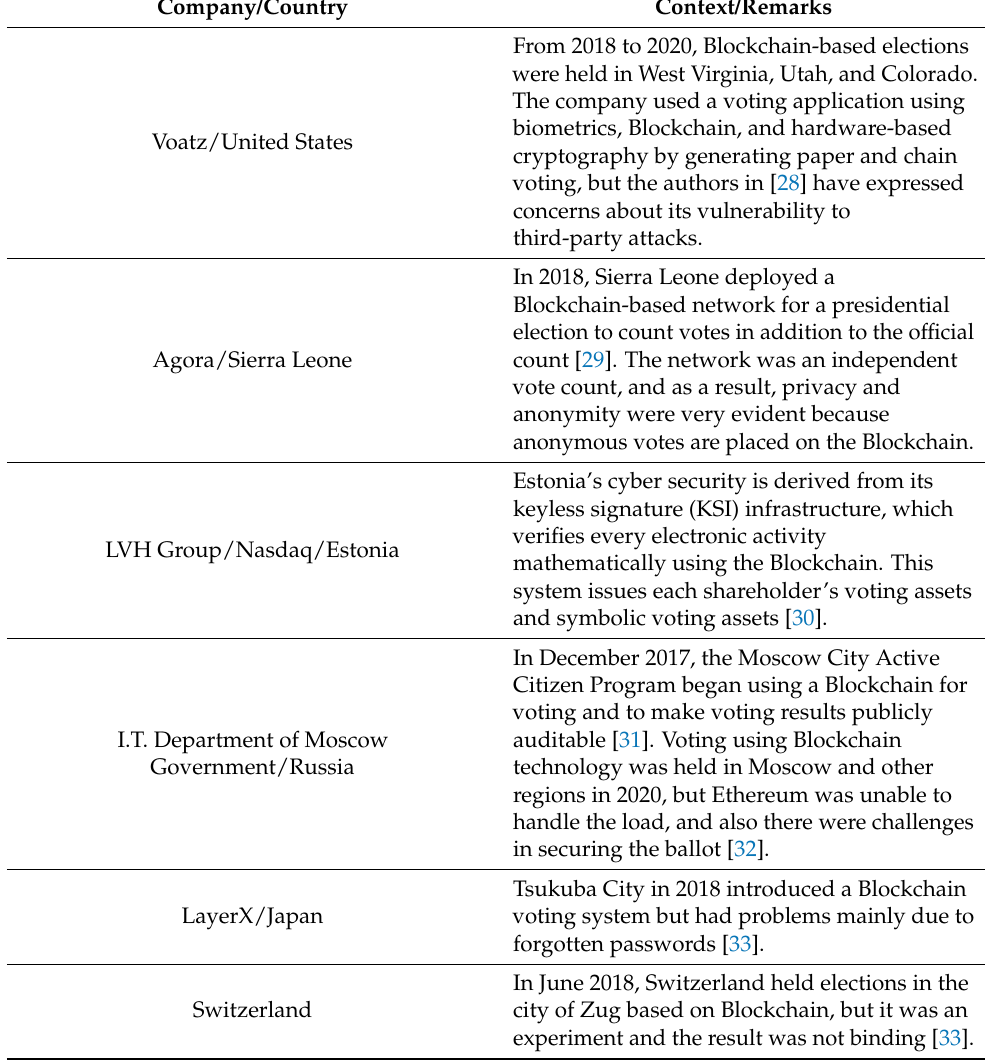
Table 1. Blockchain-based electronic voting